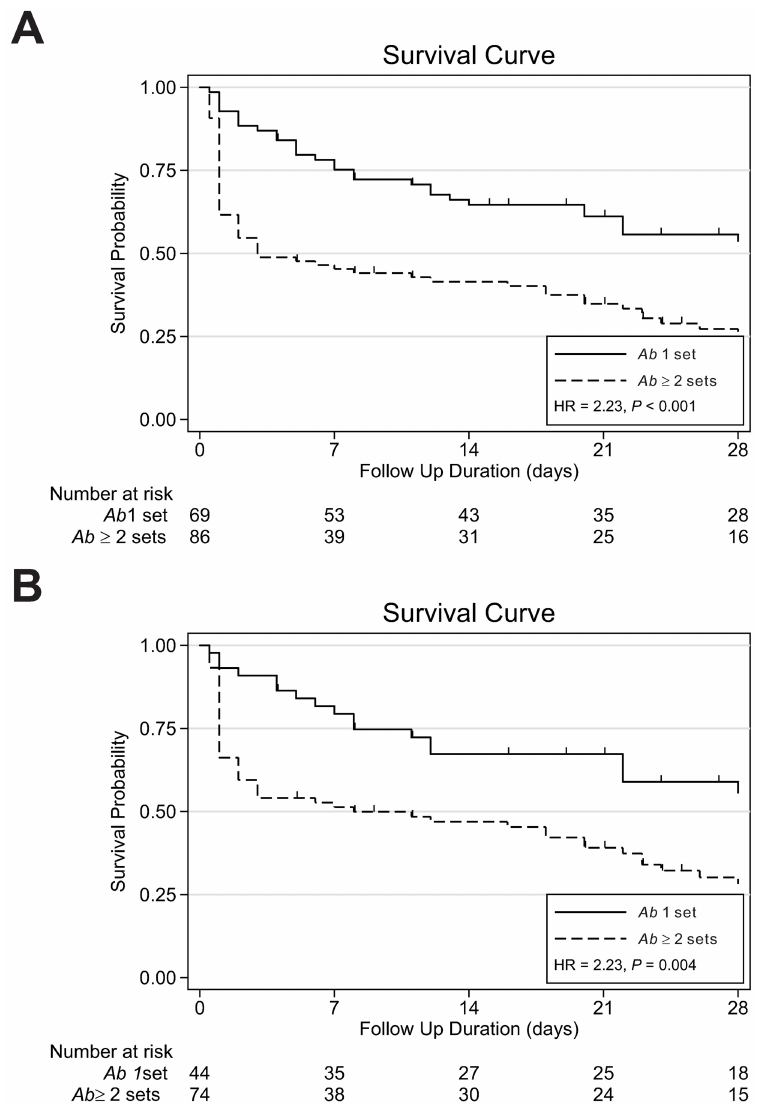
Fig 2. Kaplan-Meier stratified by 1 set and (cid:21) 2 sets blood cultures positive for A . baumannii showing inferior survival of (cid:21) 2 sets blood cultures positive for A . baumannii compared to 1 set of A . baumannii among all A . baumannii bacteremic patients (A) and among mono-microbial A . baumannii bacteremic patients (B).